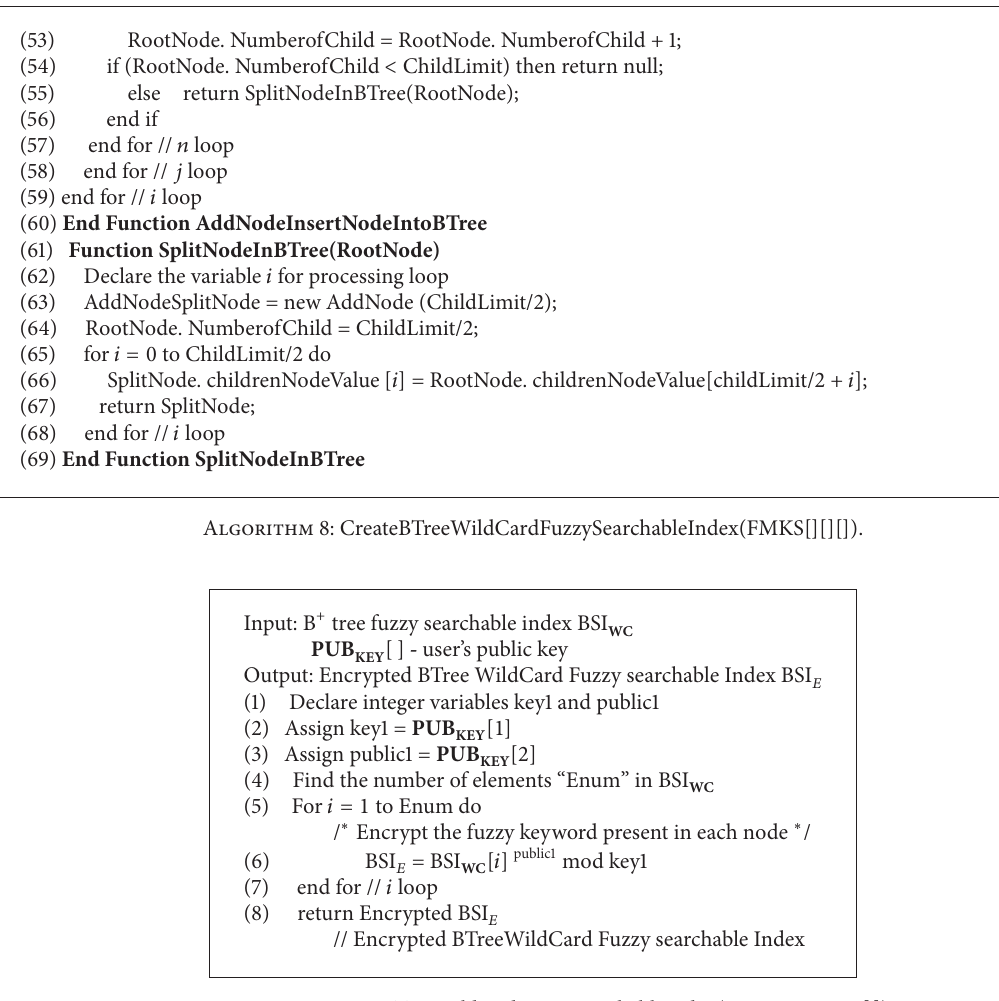
Algorithm 9: EncryptBTreeWildcardFuzzySearchableIndex(BSI